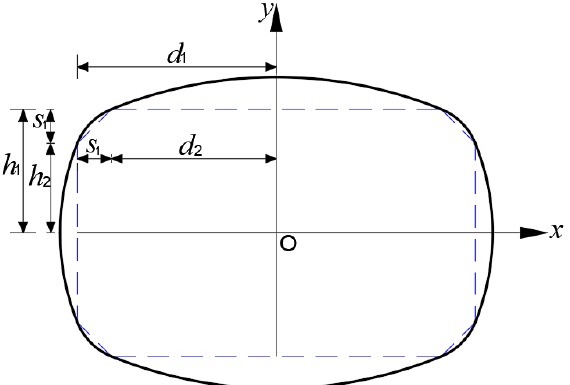
Figure 3. Cross-section of quasi-rectangular tunnel: s 1 = 0.76 m; d 1 = 4.44 m; d 2 = 3.68 m; h 1 = 2.75 m; h 2 = 1.99 m.